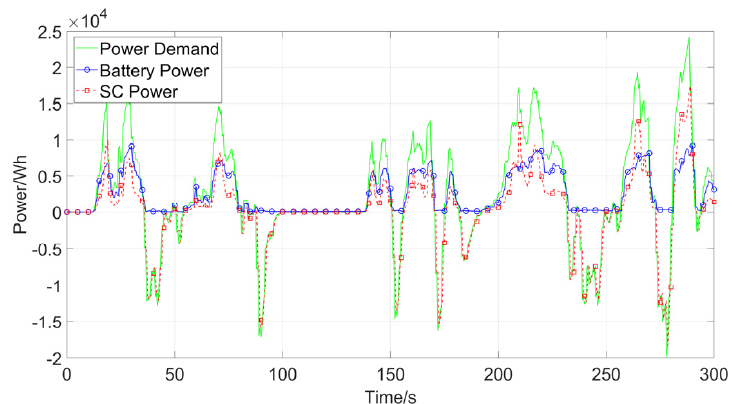
Figure 11. HESS power distribution result.